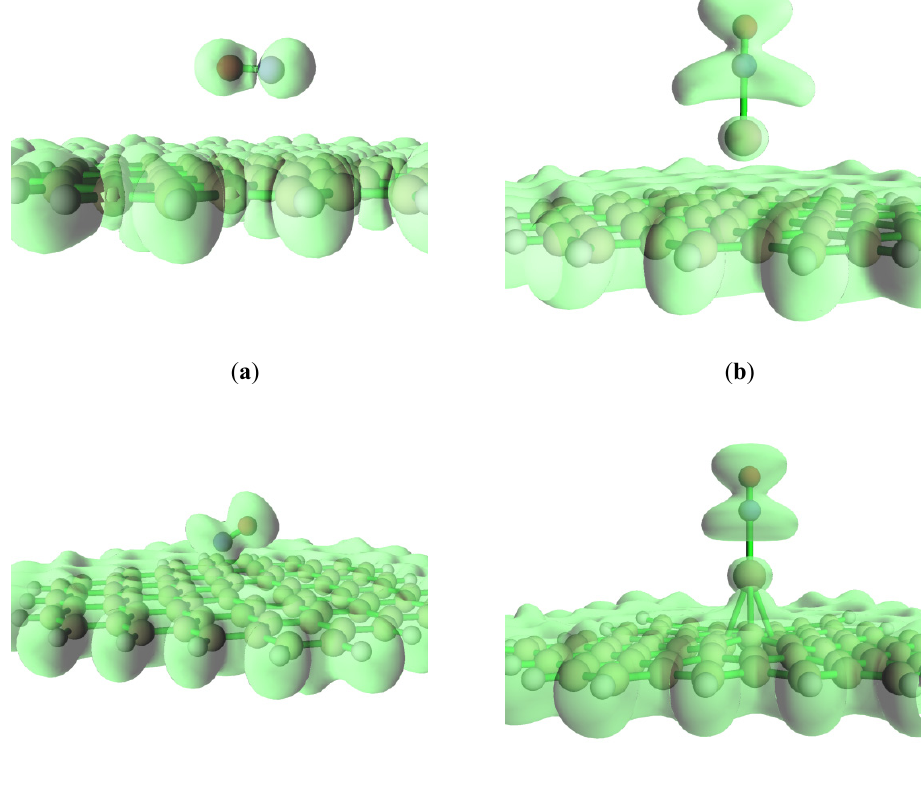
Figure 4. The isosurface map of ELF analysis at ( a ) graphene-NO, ( b ) graphene-Na-NO, ( c ) gsv-NO, and ( d ) gsv-Na-NO.